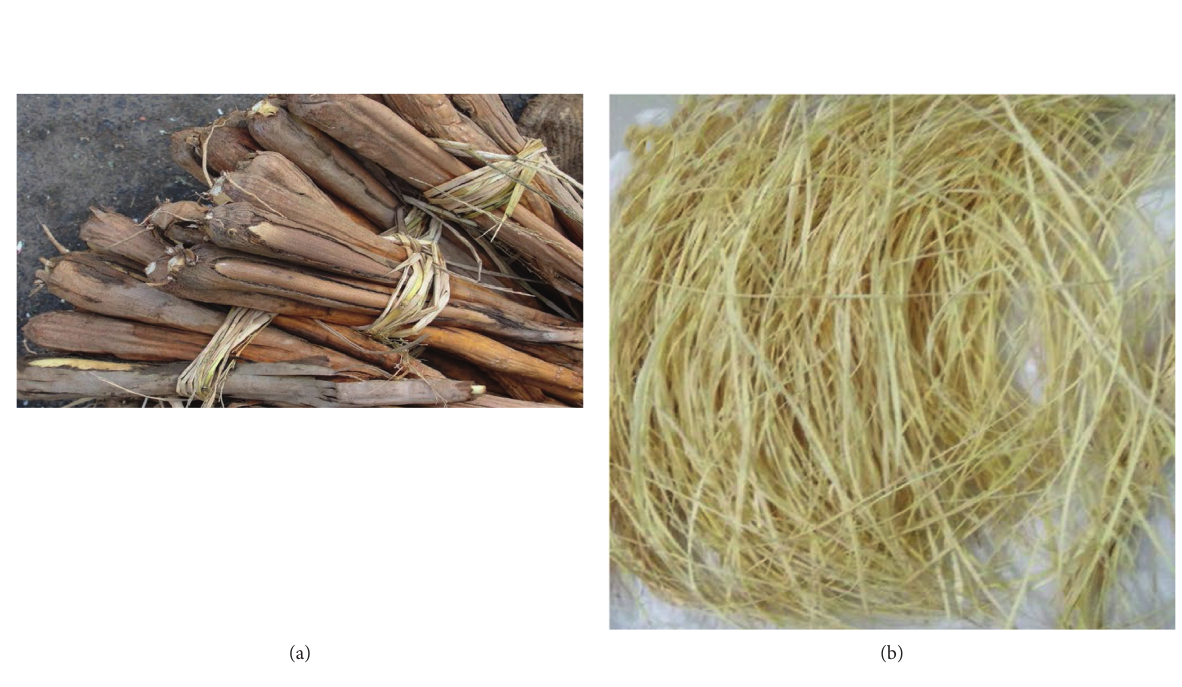
Figure 1: (a) Palmyra sprout fruit. (b) Palmyra sprout fiber.